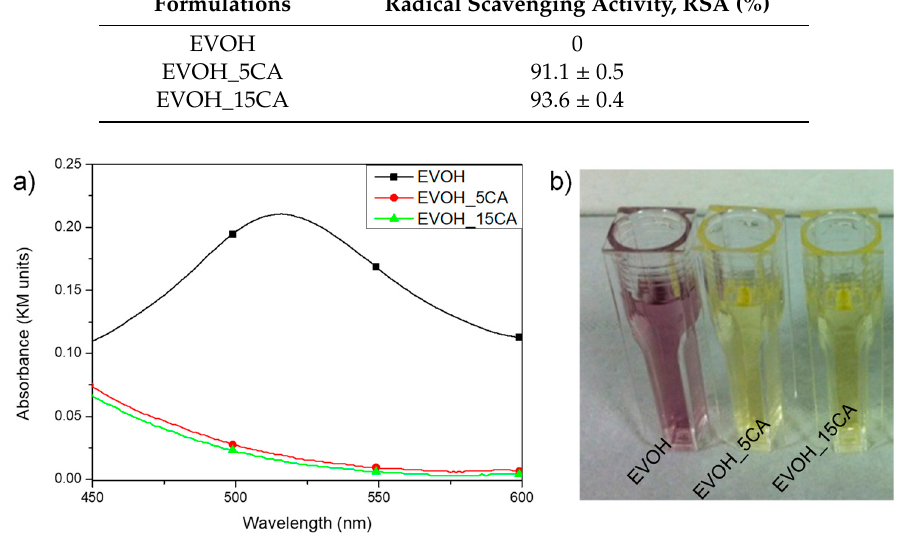
Figure 6 . Antioxidant activities of migrating substances for EVOH and EVOH_CA based formulations immersed directly in the methanol solution for 24 h: monitoring of the absorbance band at 517 nm ( a ) and colour variation of the DPPH methanol solution ( b ).